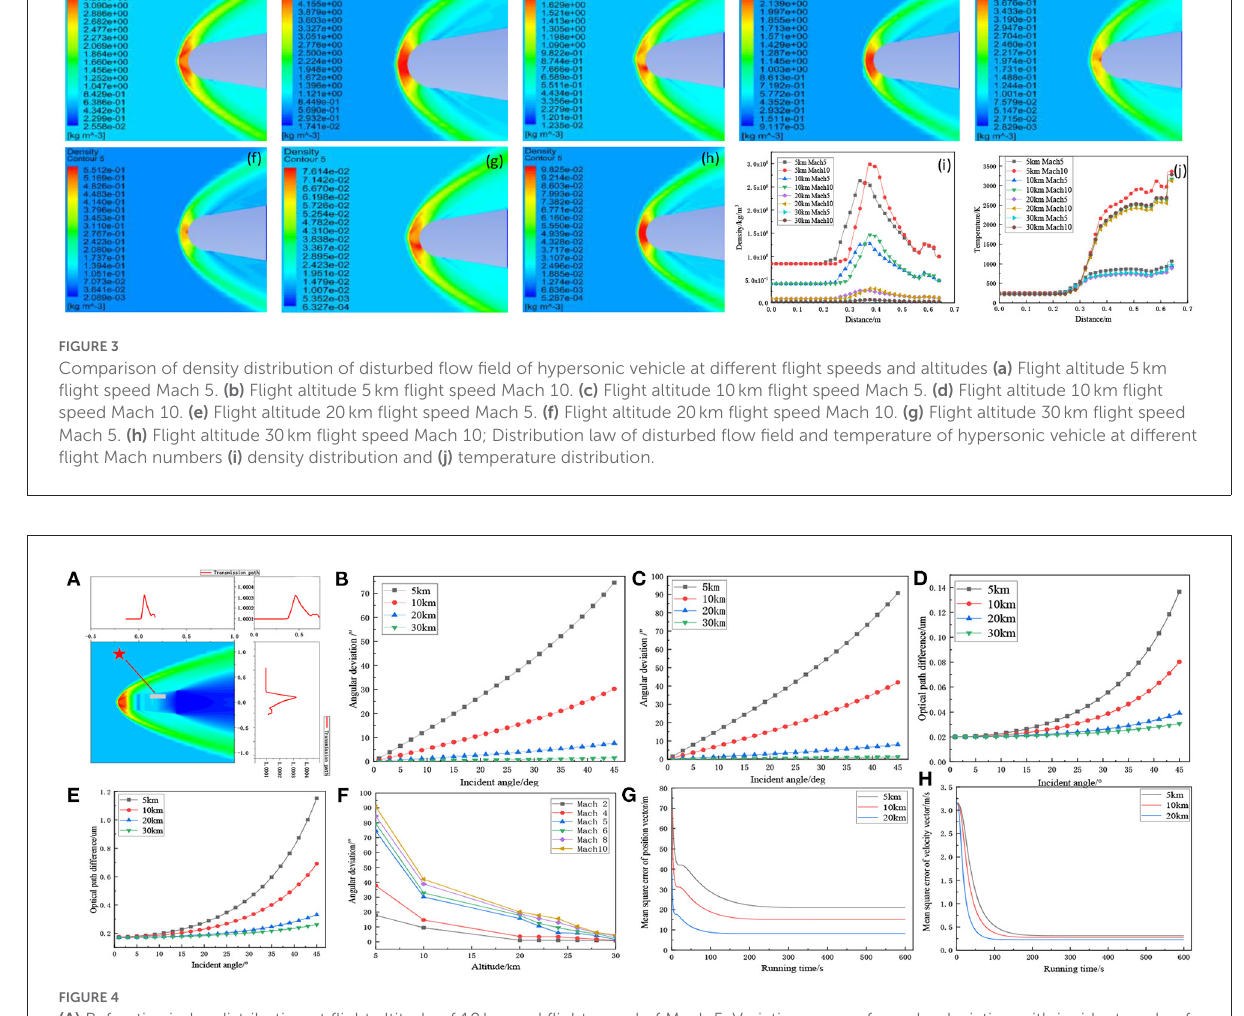
FIGURE4 (A) Refractive index distribution at flight altitude of 10km and flight speed of Mach 5. Variation curve of angular deviation with incident angle of light (B) flight speed Mach 5 and (C) flight speed Mach 10. Curve of optical path difference with incident angle of light (D) flight speed Mach 5 and (E) flight speed Mach 10. (F) Relationship between deflection angle and Mach number when the incident angle is 45 degrees and the altitudes are 5, 10, 20, and 30km, respectively; EKF filtered navigation error. (G) mean square error of position vector and (H) mean square error of velocity vector,